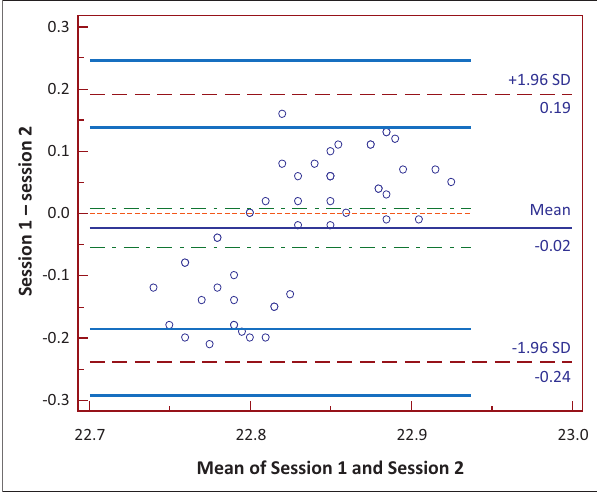
FIGURE 1: A Bland-Altman plot for Subject 3 showing inter-session reproducibility in axial length measurements (session 1 – session 2) against their combined average, with the 95 % limit of agreement depicted.